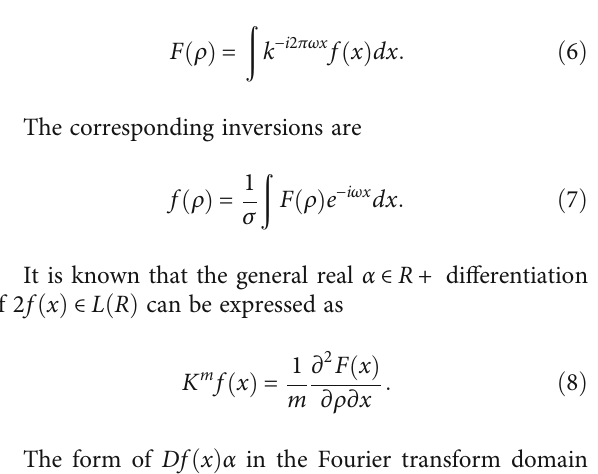
e ff ective. The literature [14] designs three di ff erent fi